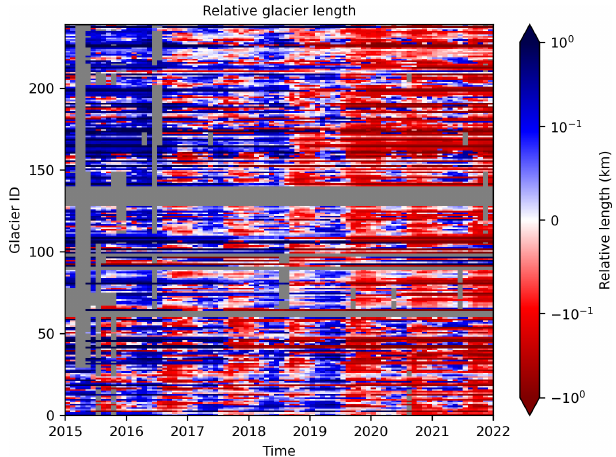
Figure 2. Glacier length relative to mean 2015–2021 length for each glacier. The Glacier ID system is derived from MEaSUREs glacier data (Joughin et al., 2021) and is detailed in Tables S1 and S2. The color scale is logarithmic with a linear threshold at ± 10 − 1 to ac- count for values approaching zero. Terminus positions that are ad- vanced relative to the mean length appear in blue, and terminus po- sitions that are retreated relative to the mean length appear in red. No-data values are gray and are due to either spatial or temporal gaps in the SAR mosaics used for digitizing terminus